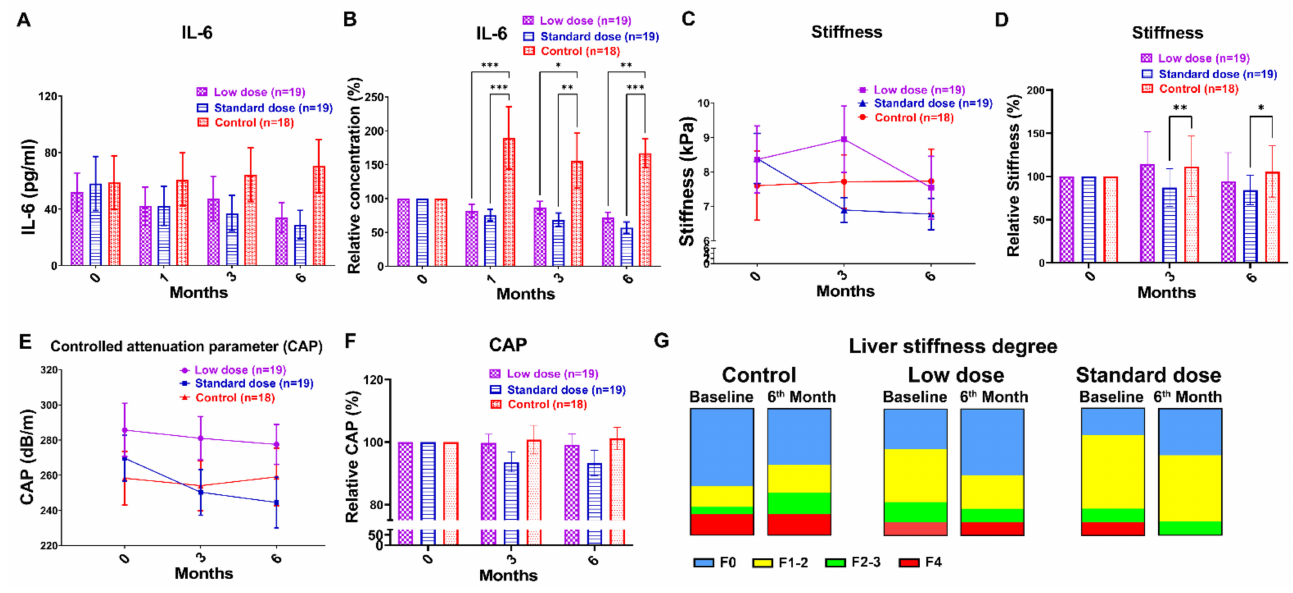
Figure 4. Arthrospira reduces interleukin 6 level, liver stiffness, and hepatic steatosis in CHB patients receiving NA treatment. ( A , C , E ) The graphs demonstrate the change in interleukin 6 (IL-6) level (pg/mL), liver stiffness (kPa), and controlled attenuation parameter (CAP, dB/m) in patients in the three groups over 6 months. ( B , D , F ) The graphs demonstrate the change from baseline of IL-6 level, liver stiffness degree, and CAP in patients in the three groups over 6 months. ( G ) The overall stiffness degree decreased in both groups with arthrospira supplementation but not in the control group. The bars show the proportion of liver stiffness degree in each group. F0: no fibrosis; F1–2: mild fibrosis; F2–3: severe fibrosis; F4: cirrhosis. The value at 0 month (before Arthrospira supplement) was as the baseline level of each patient in graphs B, D, and F. The IL-6, liver stiffness, and CAP were decreased at 6th month in both Arthrospira add-on groups. Significant reductions in relative IL-6 levels and stiffness were observed in the standard-dose group. (* p < 0.05, ** p < 0.01, *** p < 0.001, compared to control). Control group: NA only; low-dose group: oral Arthrospira at 3 g daily with NA; standard-dose group: oral Arthrospira at 6 g daily with NA. Each data point represents mean ± SEM